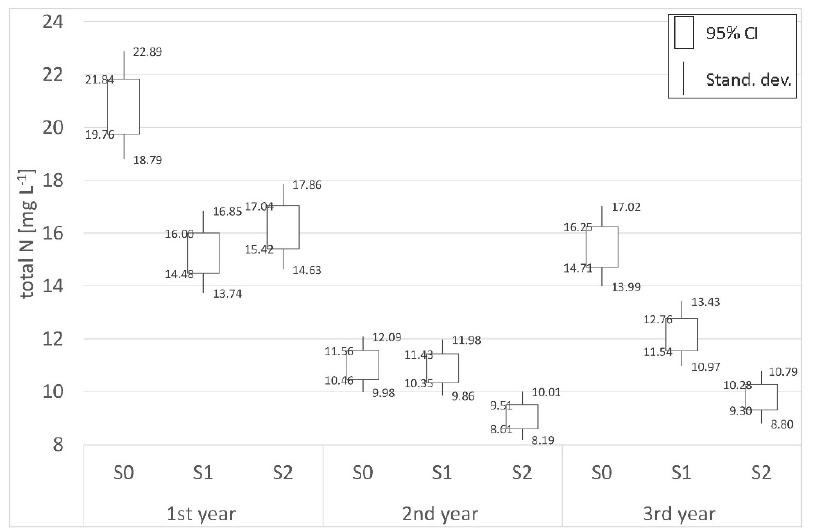
Figure 7. The concentrations of total N in groundwater under shelterbelt soils. The lowest values of NO 3 − -N concentrations were observed on peatland from 0.55 to 1.03 mg L − 1 and the highest on shelterbelt from 9.06 to 20.18 mg L − 1 (Table 6; Figures 8 and 9). In addition, NO 3 − -N concentrations decreased from the border of peatland and shelter- belt (ranged between − 11.25% and − 40.46%, and − 22.11% and − 40.21%, respectively) (Table 6). This suggests that these two elements of the landscape function as biogeochemical bar- riers. The lower values of NO 3 − -N concentrations in groundwater of peatland can indicate more intensive denitrification processes in soil. The structures of peatland with a high groundwater level favor anaerobic processes without oxygen access [50].